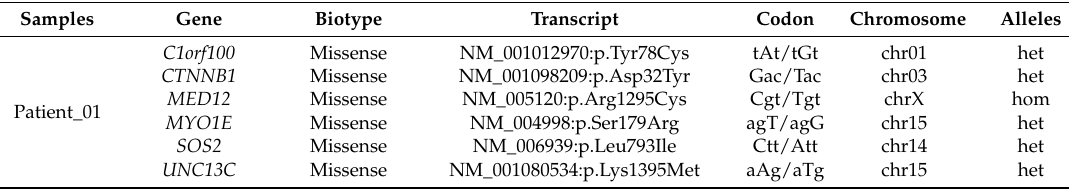
Table 2. Information of prominent SNPs in each